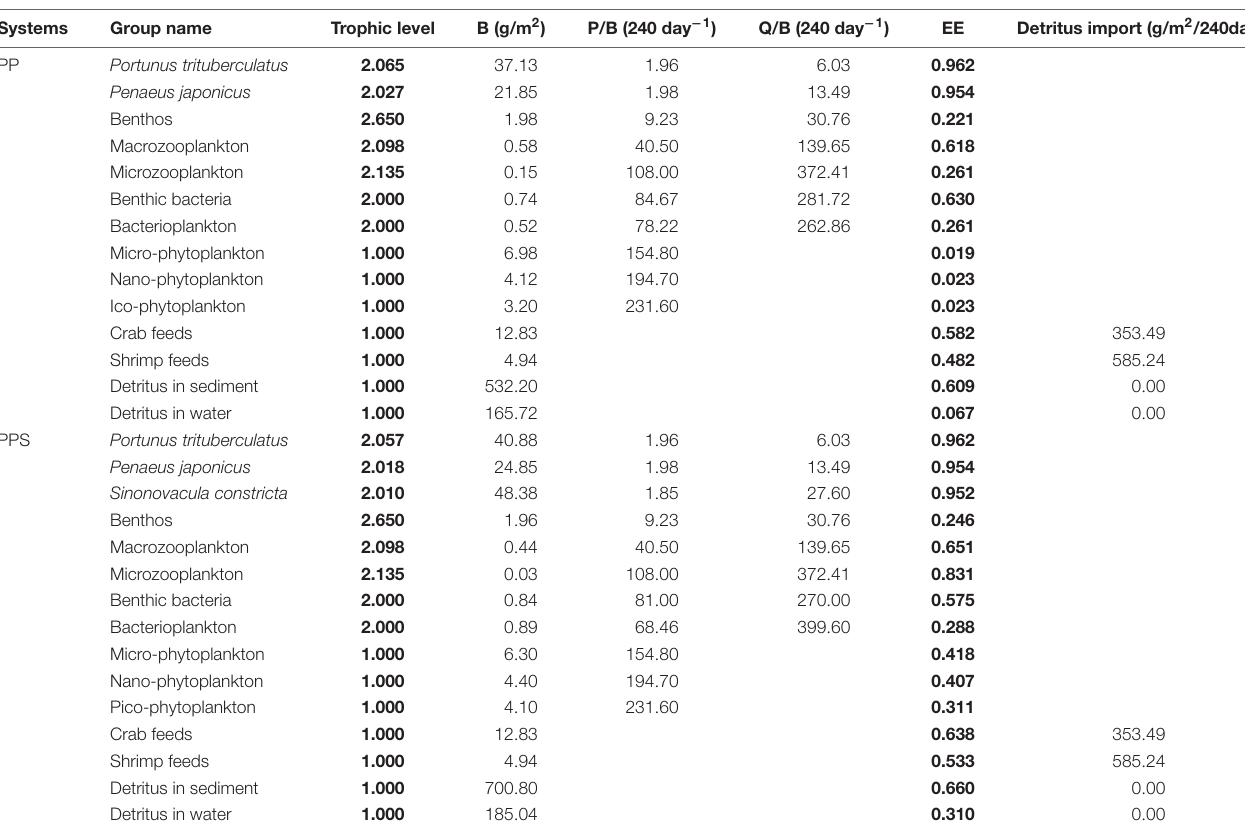
TABLE 2 | Basic input data and output parameters of Ecopath model for the two integrated pond aquaculture ecosystems.